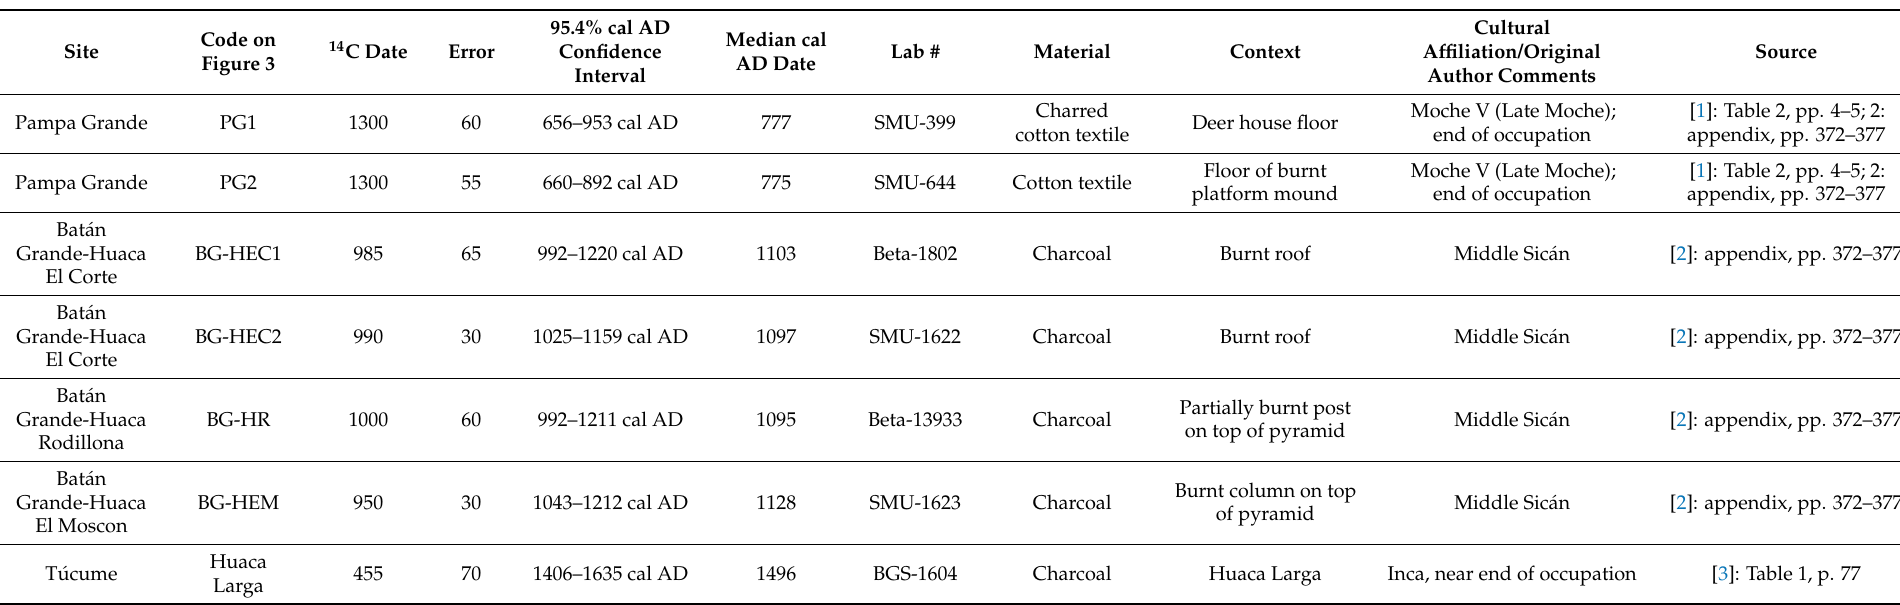
Table 1. Details of the radiocarbon dates related to the burning and abandonment of the sites of Pampa Grande, the Sic á n Precinct at Bat á n Grande, and T ú cume. The date for T ú cume is for a context sometime in the Inca occupation, which lasted for approximately 60 years prior to the abandonment of the site; the date of abandonment of T ú cume is known with precision from the historical record. The radiocarbon dates were calibrated using OxCal 4.4 [22] and the SHCal curve